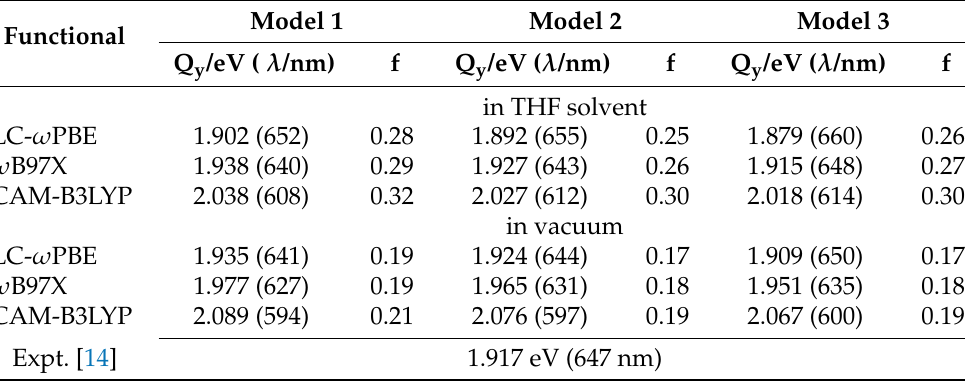
Table 2. Q y excitation energies and oscillator strengths of the three models.